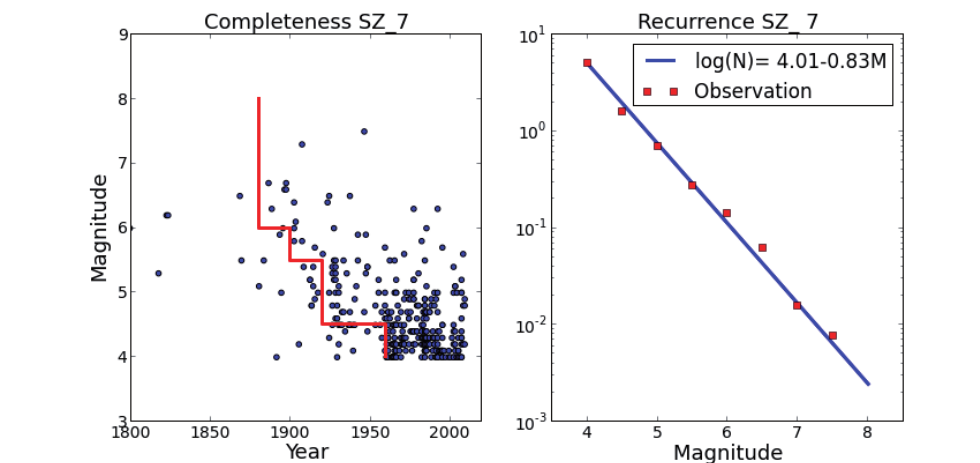
Figure 3. Completeness and recurrence plot for superzone (SZ) 7.